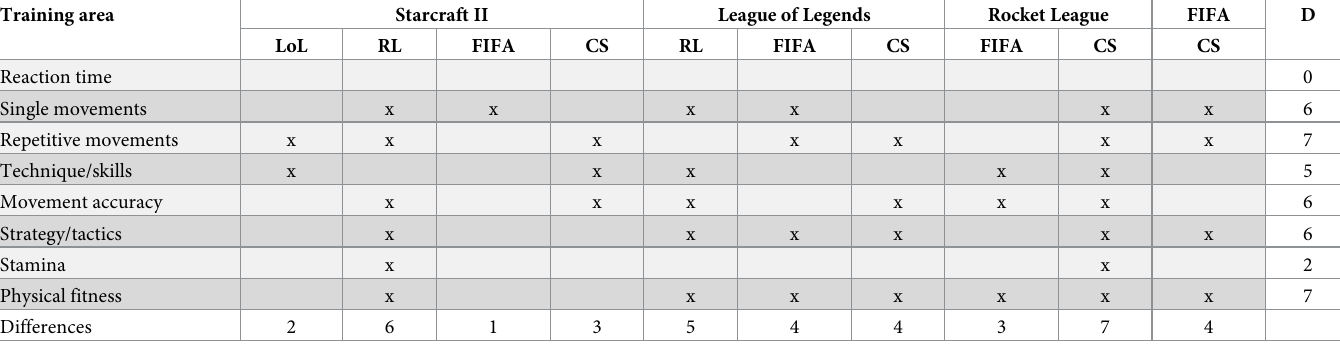
Table 16. Significant differences between the esports in the importance of specific training areas (LoL = League of Legends; RL = Rocket League; CS = Counter Strike; D = Differences). Training